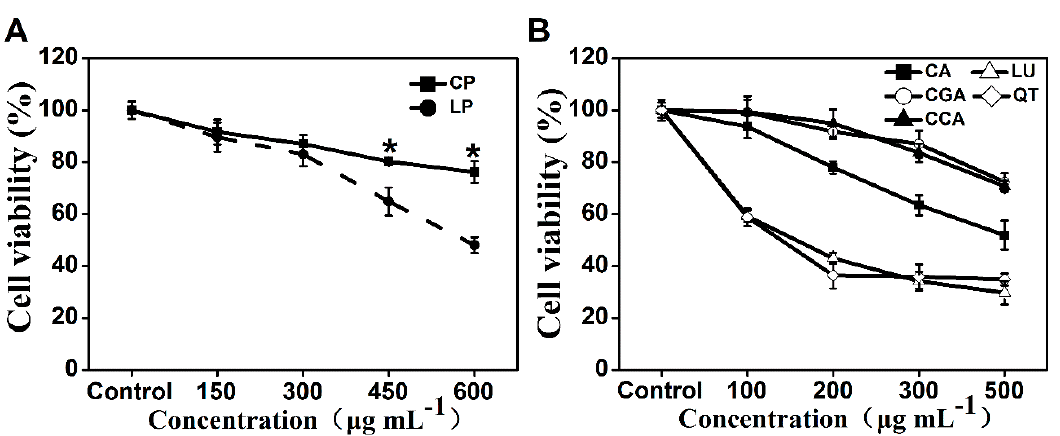
Table 1. Correlation coefficients (r) between the cell viability and phenolic profiles. The phenolic profiles are total phenolic content (TP), total flavonoids content (TF) and the individual phenolic compounds in lettuce extracts.